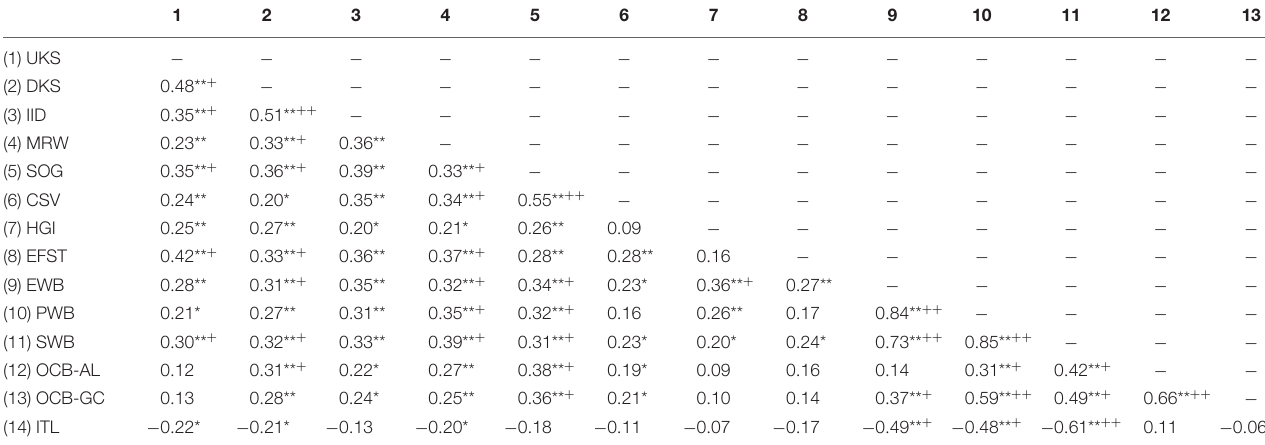
TABLE 2 | Correlations between the variables.